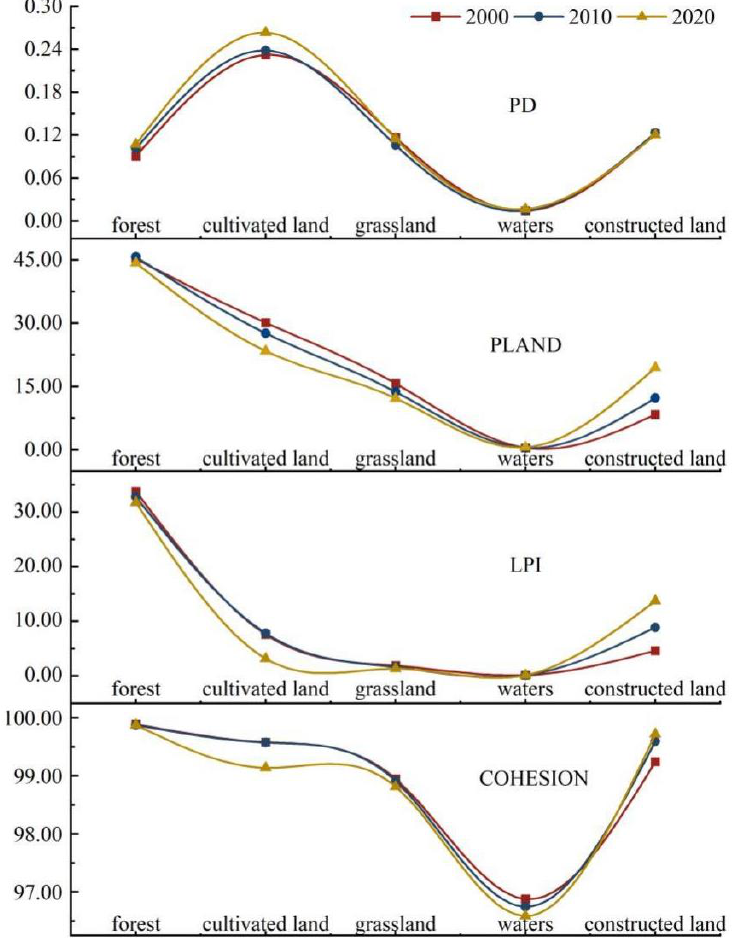
Figure 5. Change of landscape pattern index on patch type scale from 2000 to 2020.